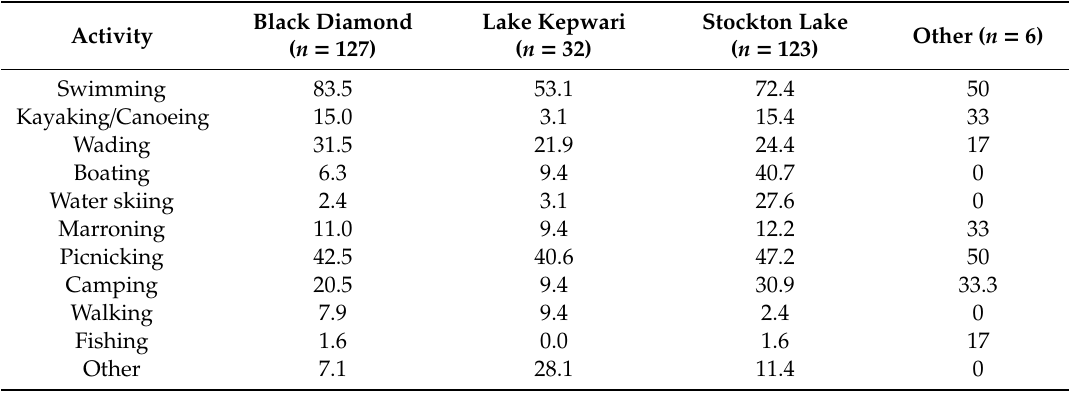
Figure 6. Wedge Pit Lake in arid Western Australia is used as a municipal potable water supply for the nearby town of Laverton.